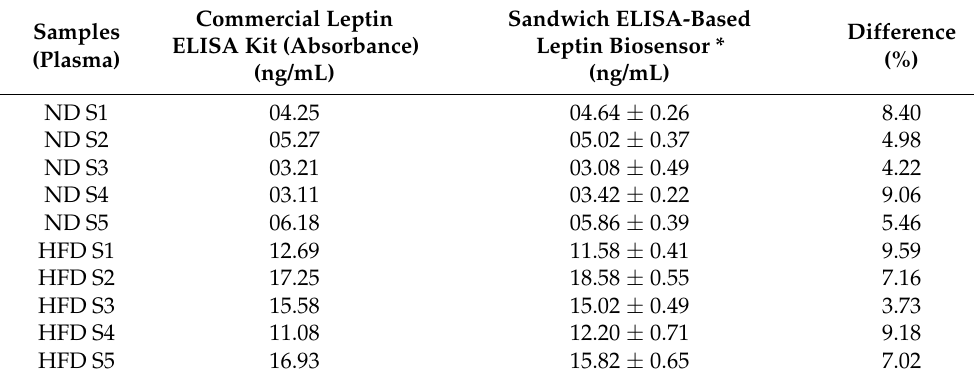
Table 2. The blood leptin levels of high-fat diet (HFD) and normal diet (ND) mice with a commercial Leptin enzyme-linked immunosorbent assay (ELISA) kit and the sandwich ELISA-based leptin